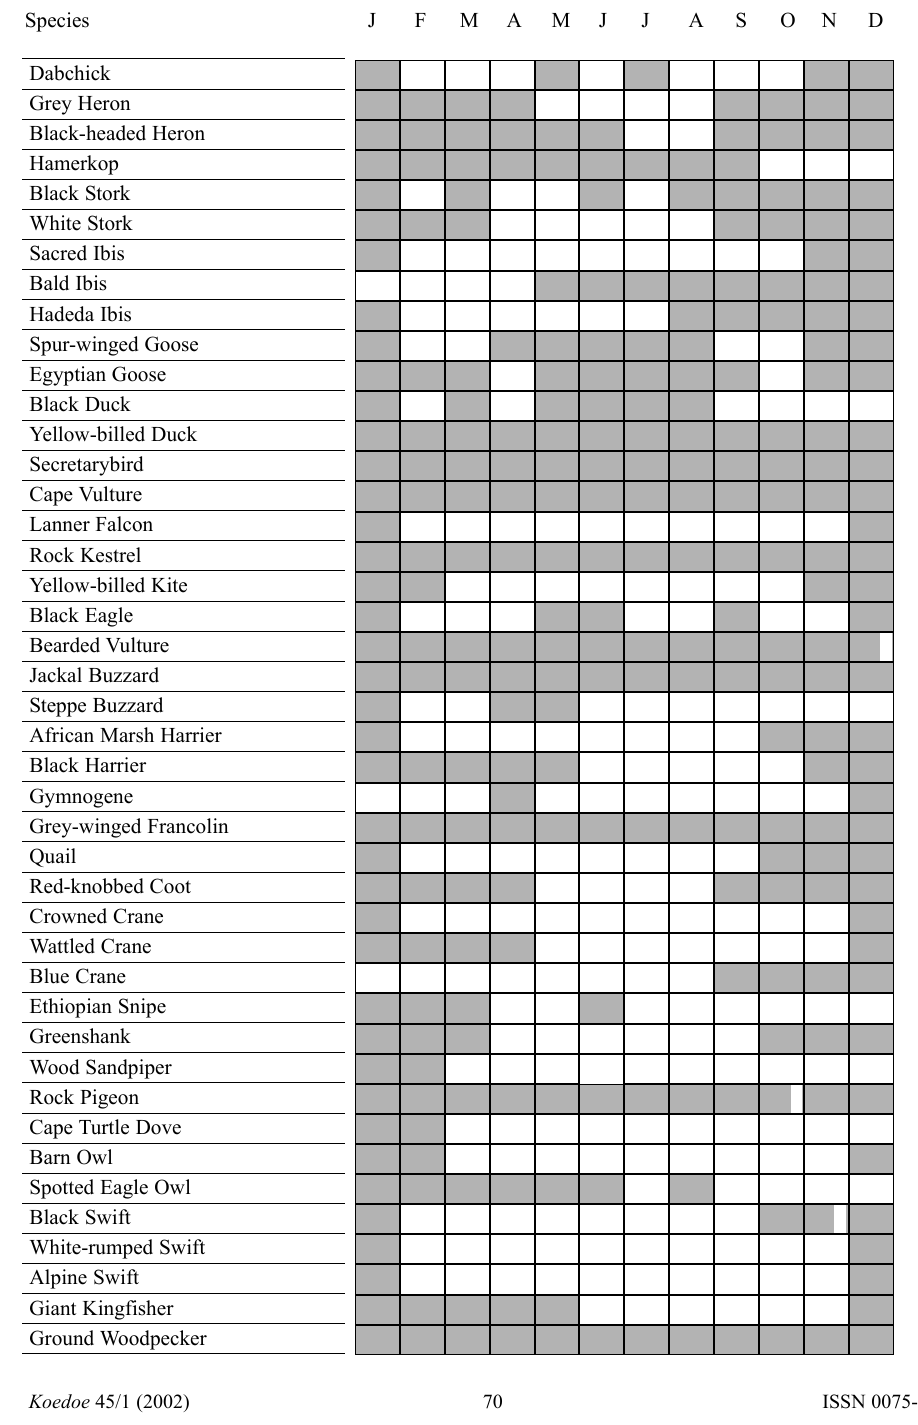
Temporal distribution of birds in Sehlabathebe National Park